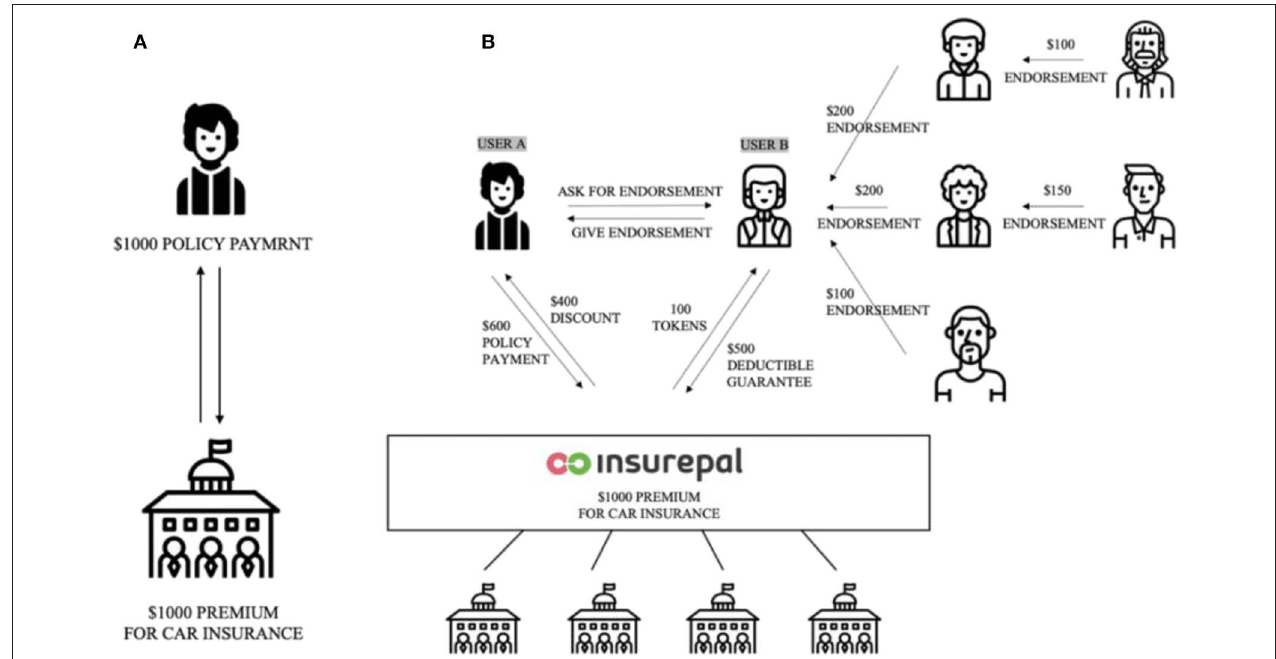
FIGURE 4 | Comparison of business processes of a car insurance premium via (A) a traditional insurance bureaucracy and (B) using InsurePal